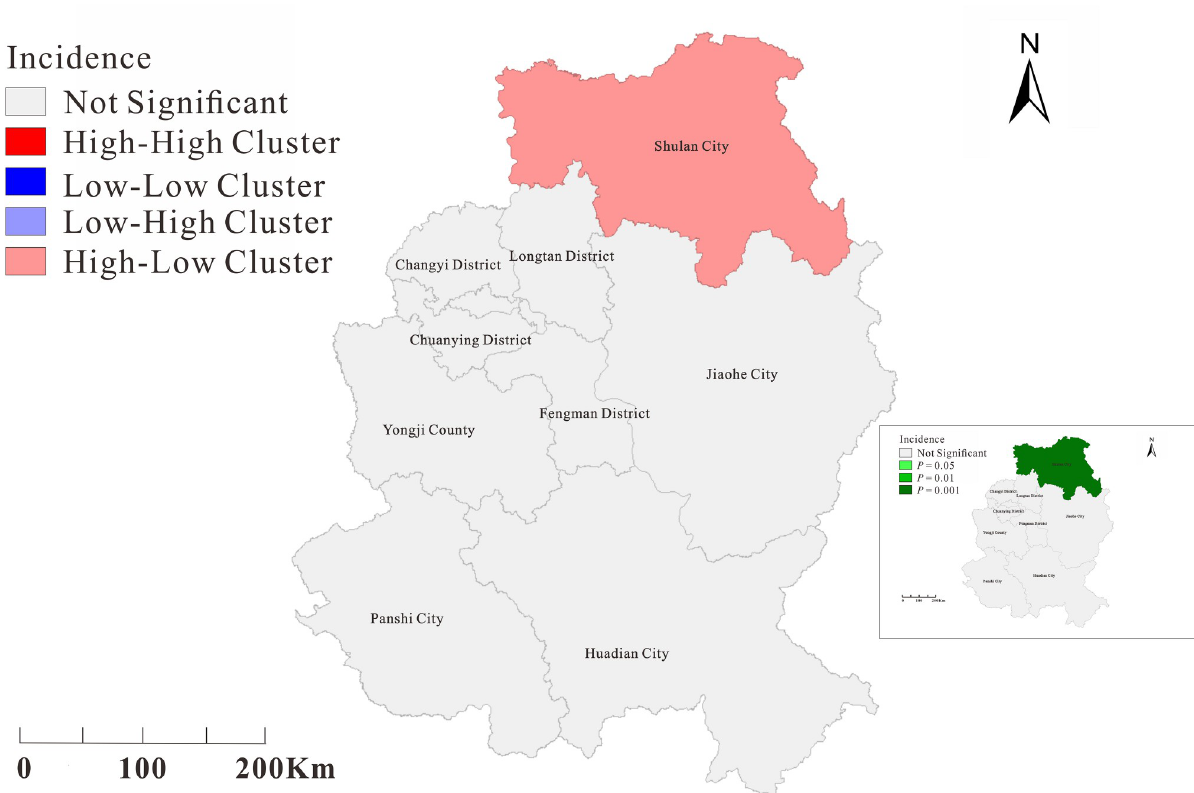
Fig 5. Local spatial autocorrelation analysis of the second phase of COVID-19 incidence in Jilin Province. The map depicted in this figure was taken from Datamap (http://datamaps.github.io/).